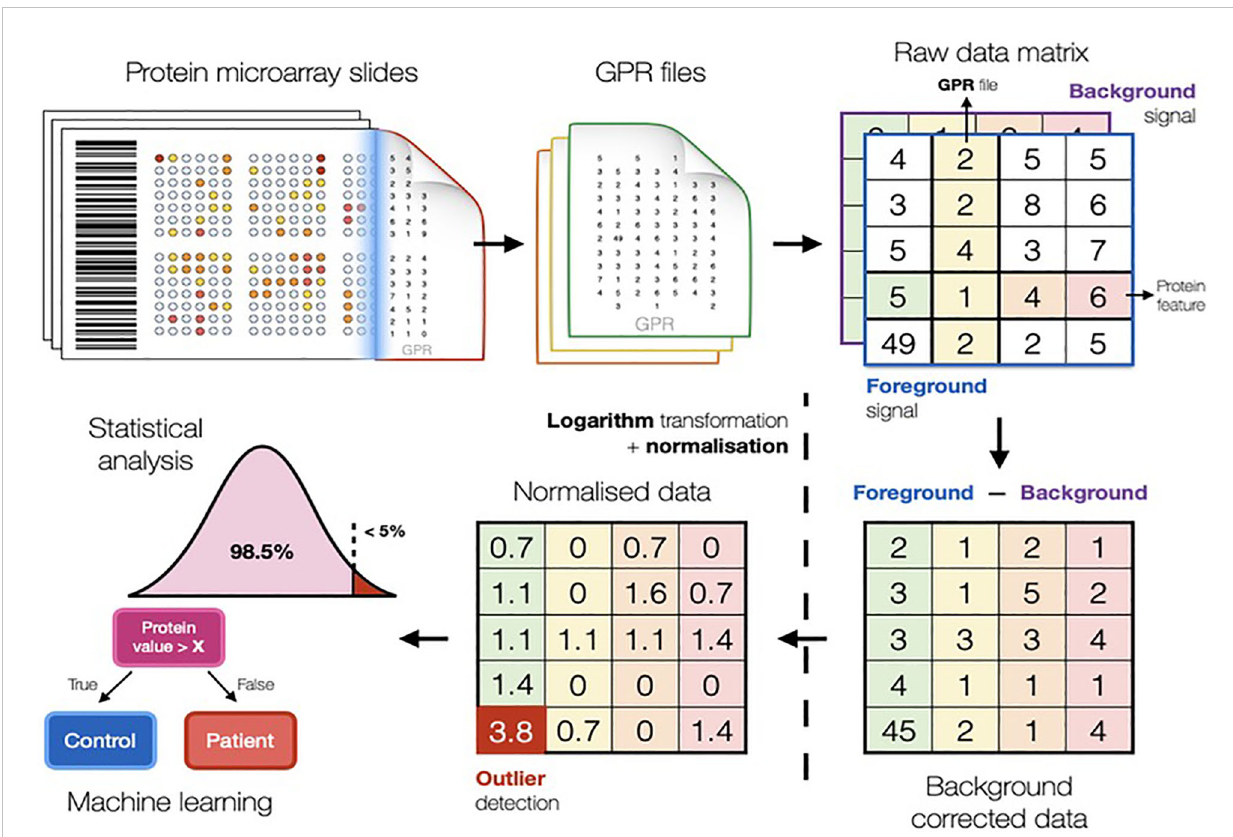
FIGURE 1 Scheme illustrating the typical computational methods used in biomarker discovery studies to analyse data. The pipeline in fi gure refers to the conventional protein microarray analysis (Fishman et al.